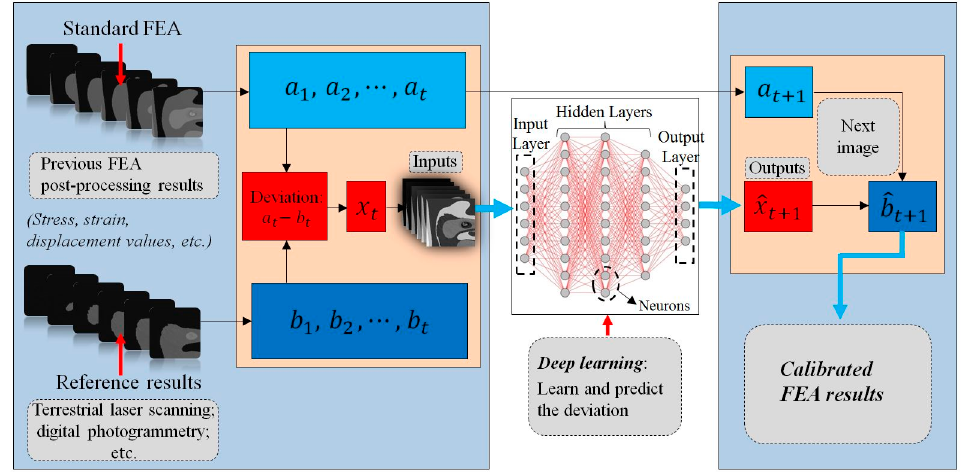
Figure 1. Framework of the proposed methodology.